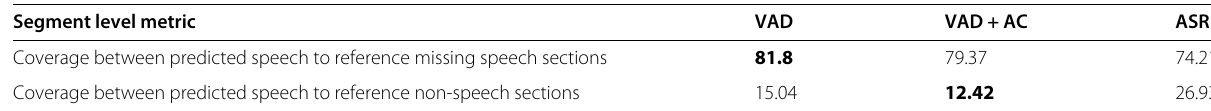
Table 4 Analysis on synthetic dataset Segment level metric